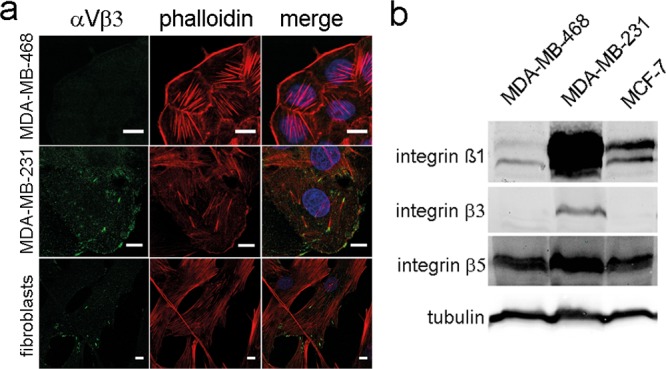
Expression of β-integrin subunits in human breast cancer cell lines.The expression of, αVβ3-, β1-, β3-, and β5- integrin in MDA-MB-468, MDA-MB-231 and MCF-7 cells was studied by confocal immunofluorescence (αVβ3) (a) or western blotting(β1-, β3-, β5-) (b), respectively, as described in Figs 3 and 5. Only MDA-MB-231 cells showed expression of (αV)β3-integrin, in partial colocalization with actin stress fibers in a fibroblast-like pattern. All breast cancer cell lines studied expressed β1-, and β5- integrin subunits (b), albeit in different quantities.